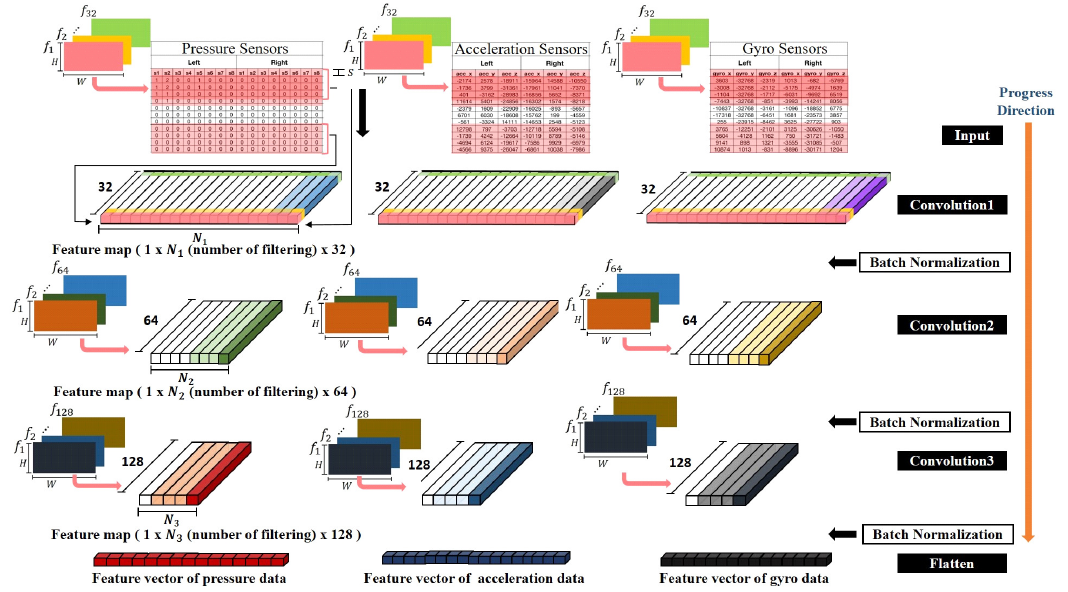
Figure 7. Structure of an individual DCNN for each sensor